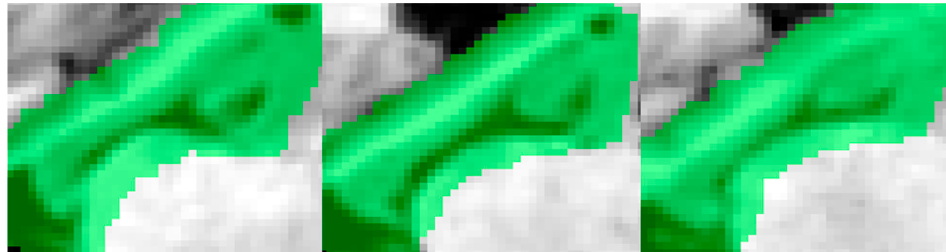
Figure 2. Three sagittal MRI bounding boxes and hippocampal ROIs (green), corresponding to three different patients. The ROI includes the hippocampus, and part of the white matter, Cerebro Spinal Fluid (CSF), and amygdala.